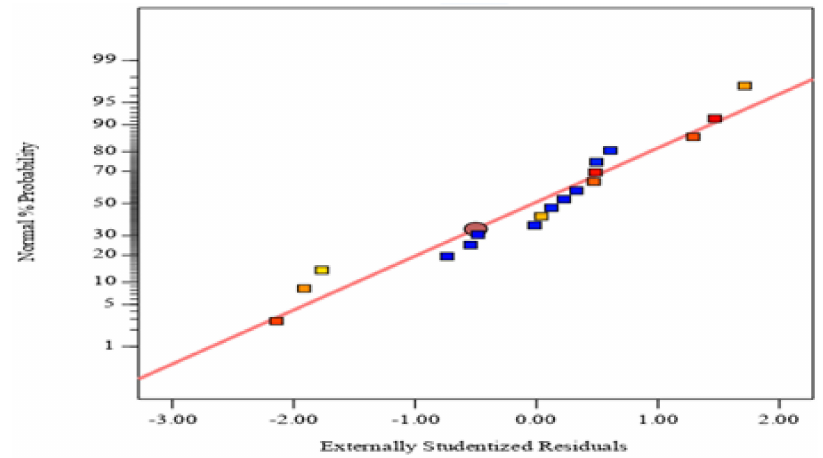
Figure 8. Plot of normality of 2FI